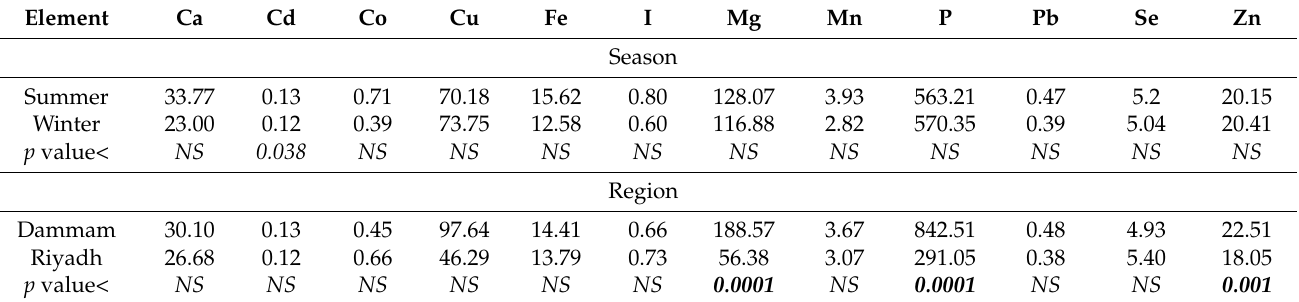
Table 7. Mean values of minerals in camel rumen tissues according to region and season [ µ g/g wet